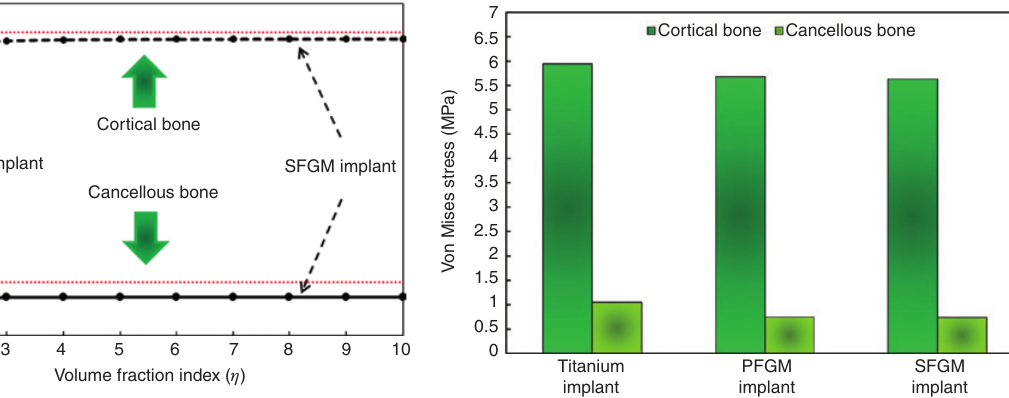
Figure 4: Maximum von Mises stress of cortical and cancellous bones in response to the axial FGBM implant.